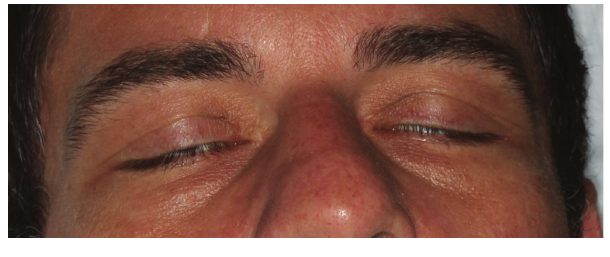
HIV infection and referred to the infectious disease clinic